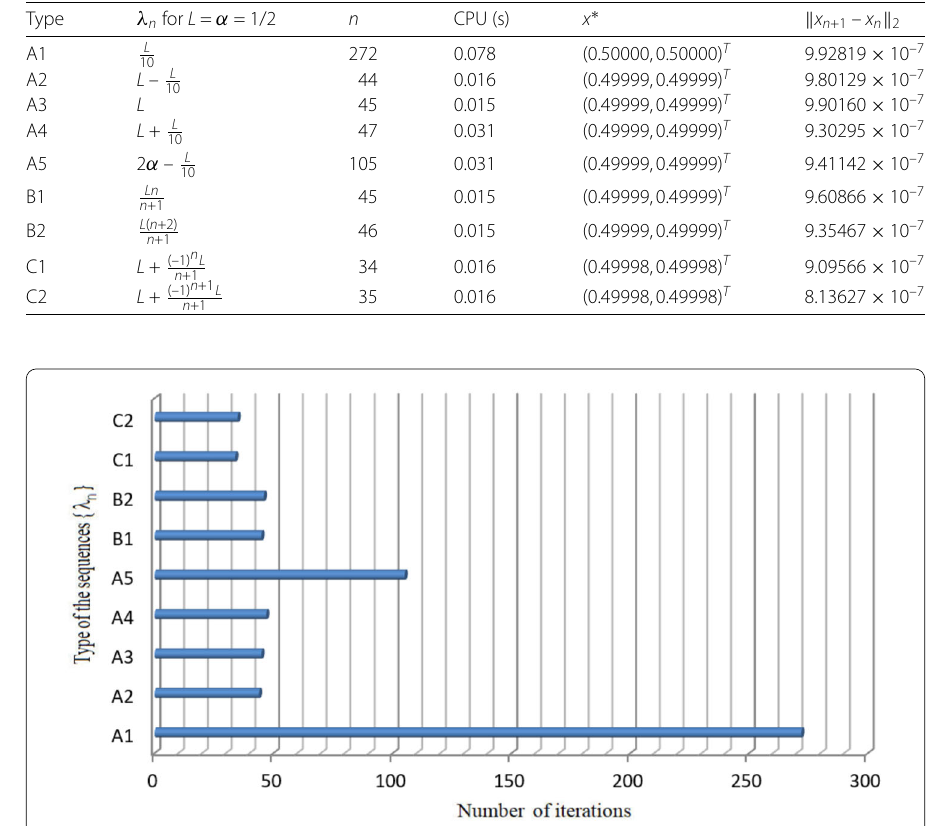
Figure 1 Benchmark for all choice types of the sequences { λ n } in Example